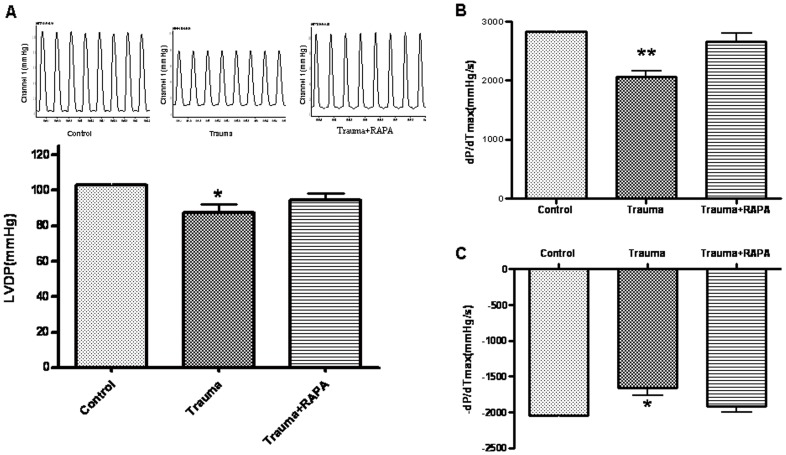
Cardiac function in isolated perfused hearts 24 h after trauma.(A) Nonlethal mechanical trauma resulted in significant decrease in left ventricular developed pressure(LVDP), which was prevented by administration of rapamycin (RAPA) 30 min before trauma. (B and C) Mechanical trauma resulted in significant decrease in the maximal positive and negative values of the instantaneous first derivative of left ventricular pressure (LVP, +dP/dtmax and -dP/dtmax) in isolated perfused hearts 24 h after trauma, which was prevented by administration of RAPA 30 min before trauma. Data are expressed as Mean±SD (n = 6). * p<0.05; ** p<0.01.